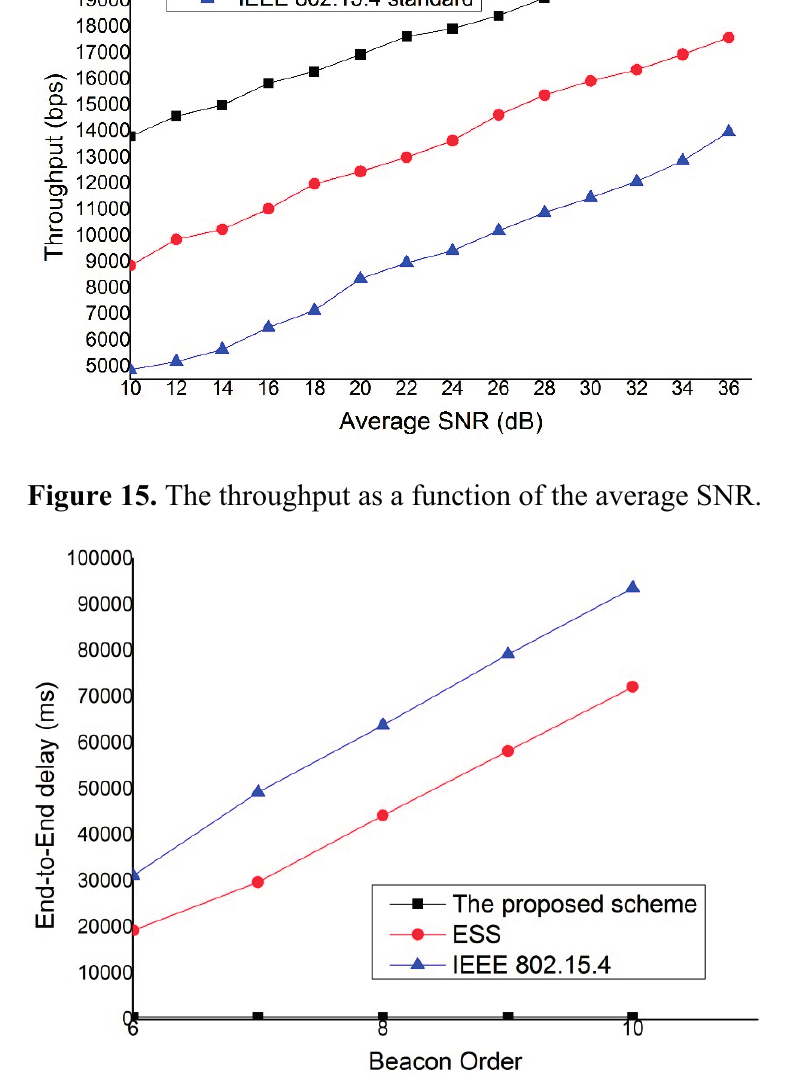
Figure 16. End-to-End delay according to beacon